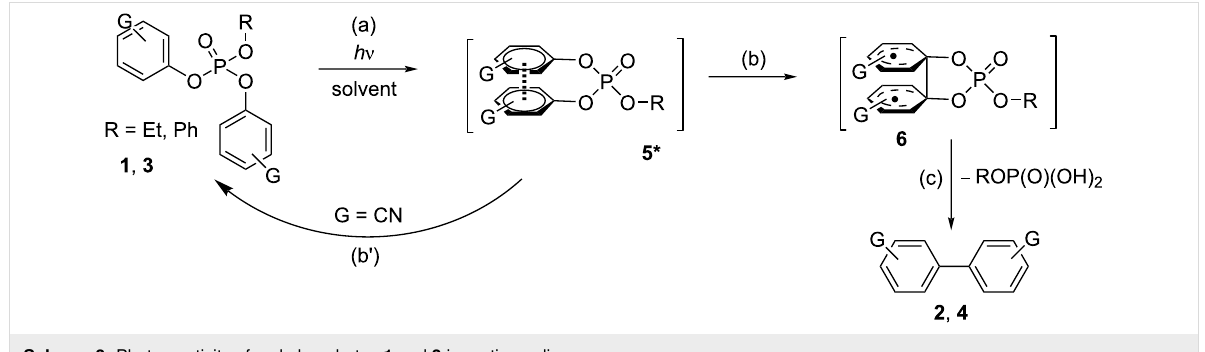
Scheme 3: Photoreactivity of aryl phosphates 1 and 3 in protic media.